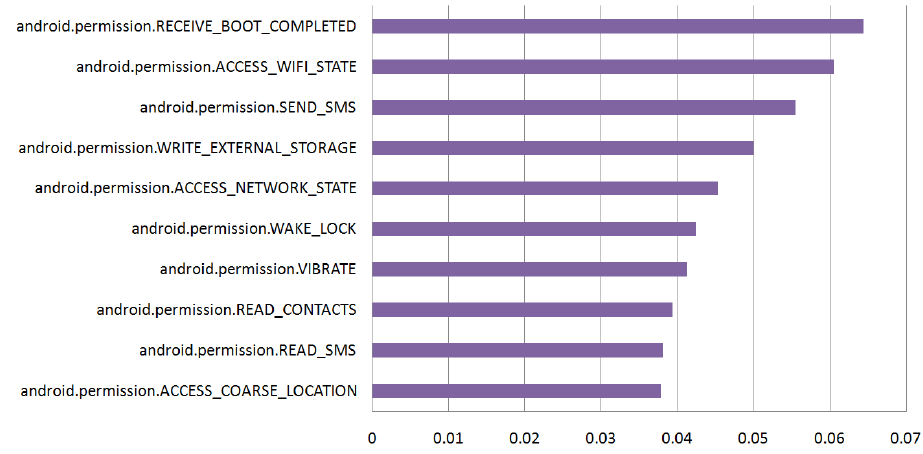
Figure 3. Feature importance of the top 10